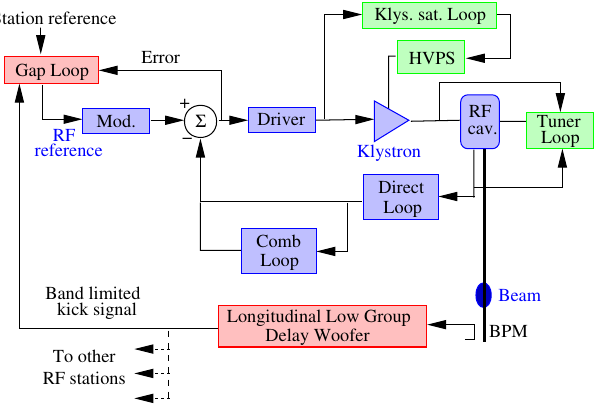
FIG. 1. (Color) The rf station block